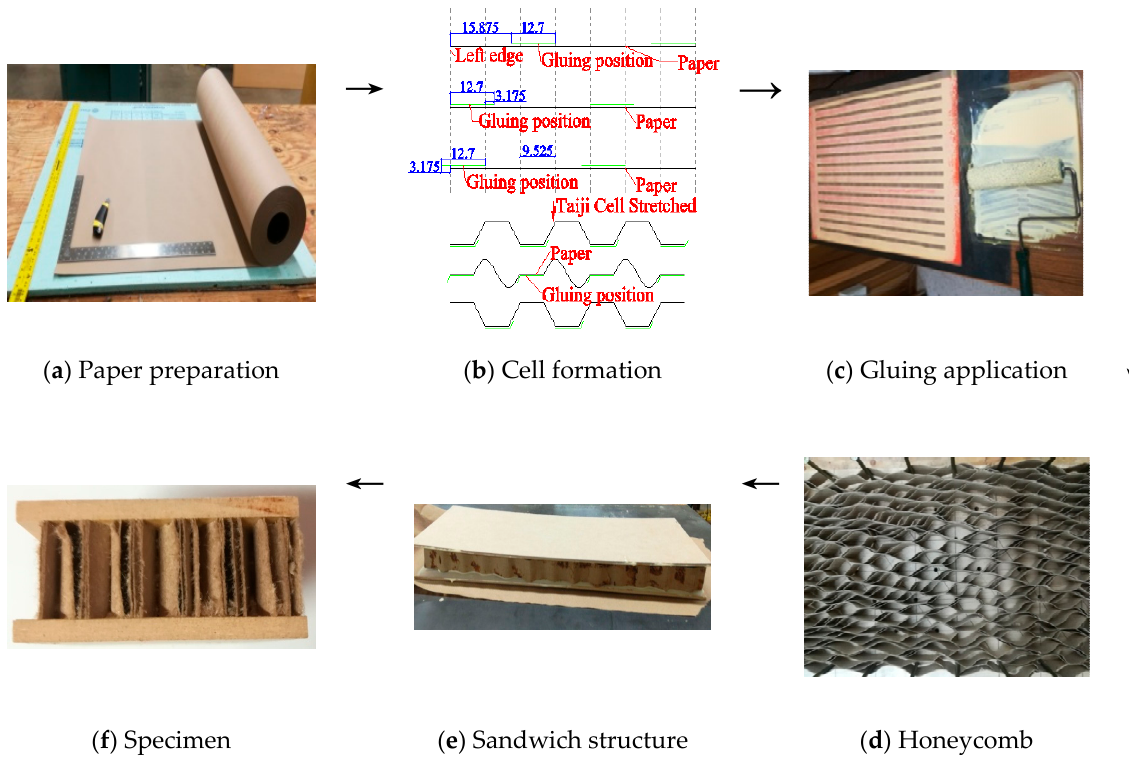
Figure 2. Fabrication of wooden sandwich beam specimens with Taiji honeycomb core.